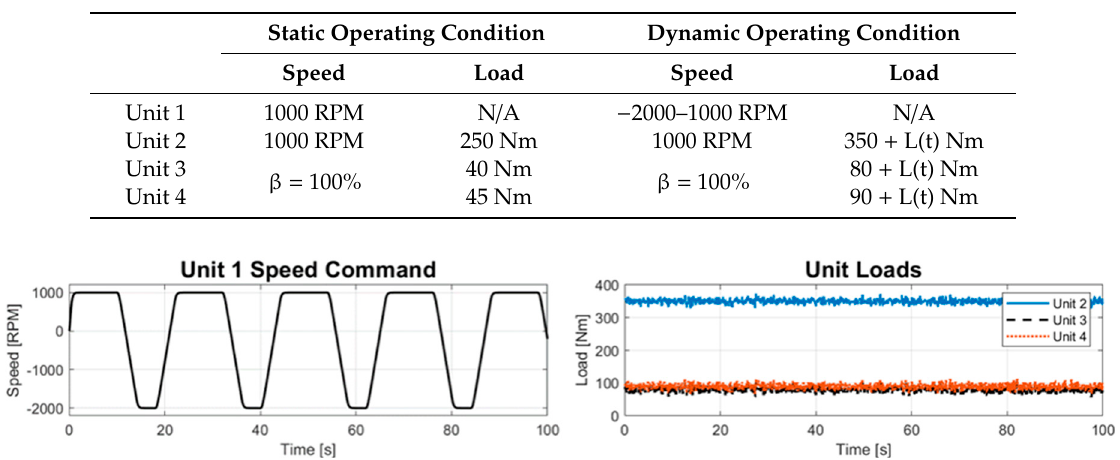
Table 3 . Inputs to simulation.